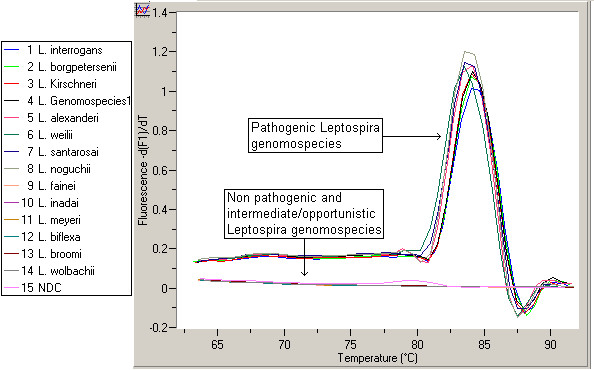
Melting curve analysis of the gyrB gene using Sybr green detection.